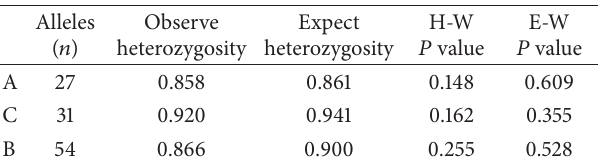
Table 1: The Hardy-Weinberg’s equilibrium observe heterozygosity, expect heterozygosity and Ewens-Watterson test of neutrality for HLA-A, -B, and -C loci in Yunnan